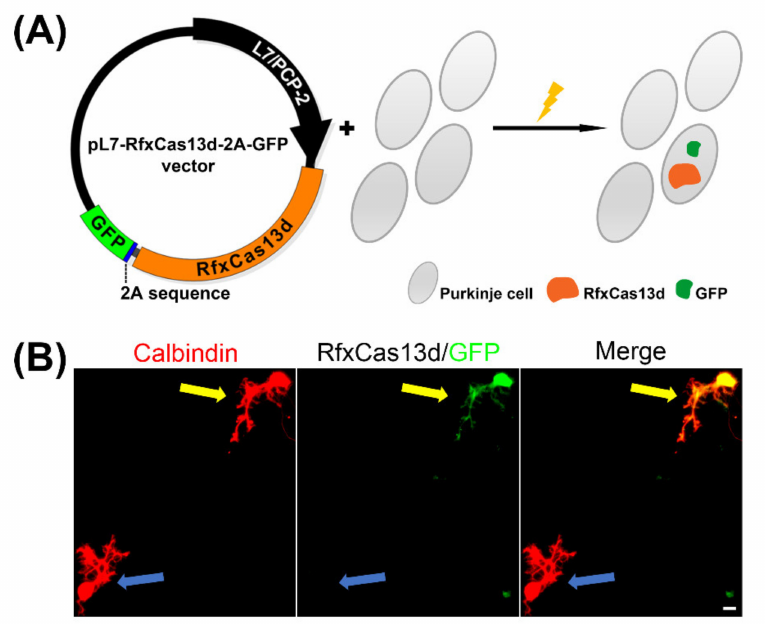
Figure 1. Purkinje-specific RfxCas13d expression. ( A ) A schematic view of the Purkinje-specific RfxCas13d expression construct; ( B ) Two Purkinje cells identified by the marker Calbindin (red) after two weeks in primary cerebellar cell culture. A RfxCas13d-2A-GFP transfected Purkinje cell (yellow arrow) and a non-transfected Purkinje cell (blue arrow) can be observed and distinguished by the presence of the GFP tagging protein. Scale bar is 20 µ